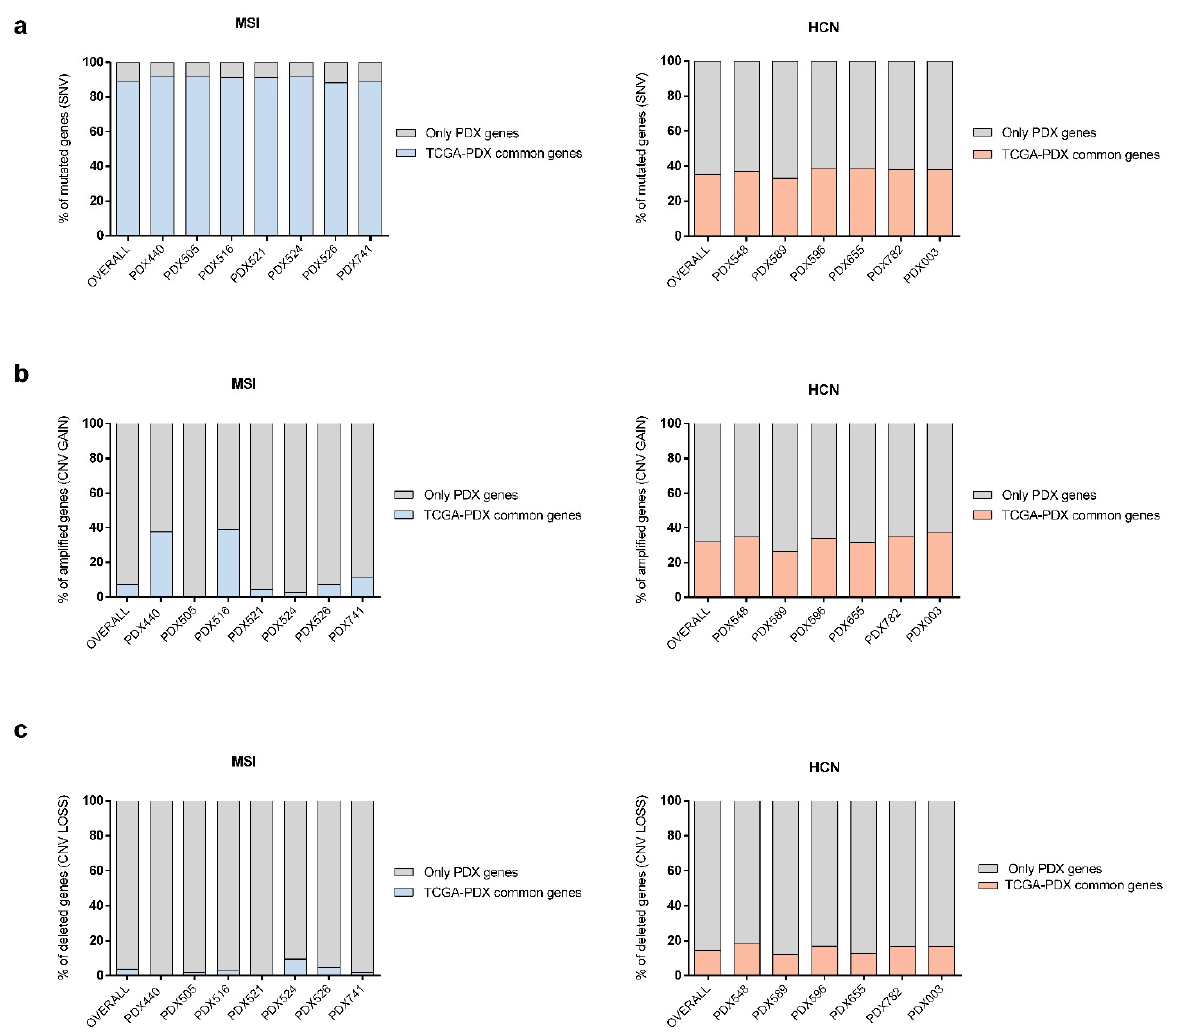
Figure 5. Comparative analysis of PDX tumor molecular variants and EC patient from the TCGA database. ( a ) Bar-plots showing the percentage of common mutated genes carrying SNVs for each PDX model compared to the endometrioid/MSI (( left panel ), blue) or serous/HCN (( right panel ), orange) patients from the PanCancer Atlas study (TCGA consortium). Grey bars show the percentage of unique SNV genes present solely in the PDX samples. ( b , c ) Comparison of the percentage of genes associated with CNV GAIN ( b ) or LOSS ( c ) events in PDX tumor. vs. patient’s from the above mentioned TCGA study. Colored bars (MSI, blue; HCN, orange) represent the percentage of common genes between the PDX tumor sample and patient from TCGA, while grey bars show the unique SNV/CNV genes present only in the PDX tumor sample.